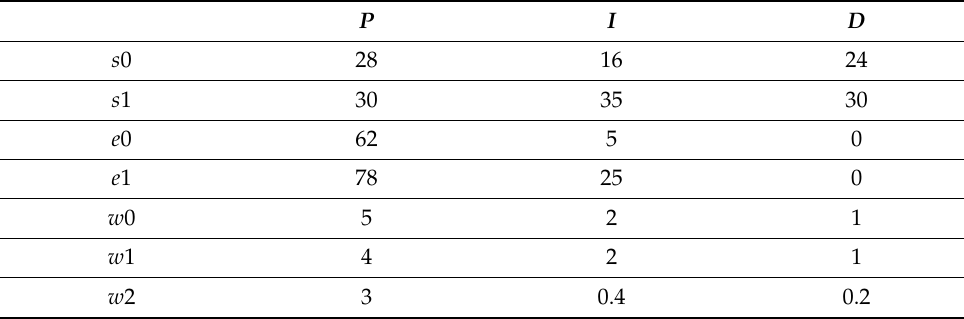
Table 2. Setting